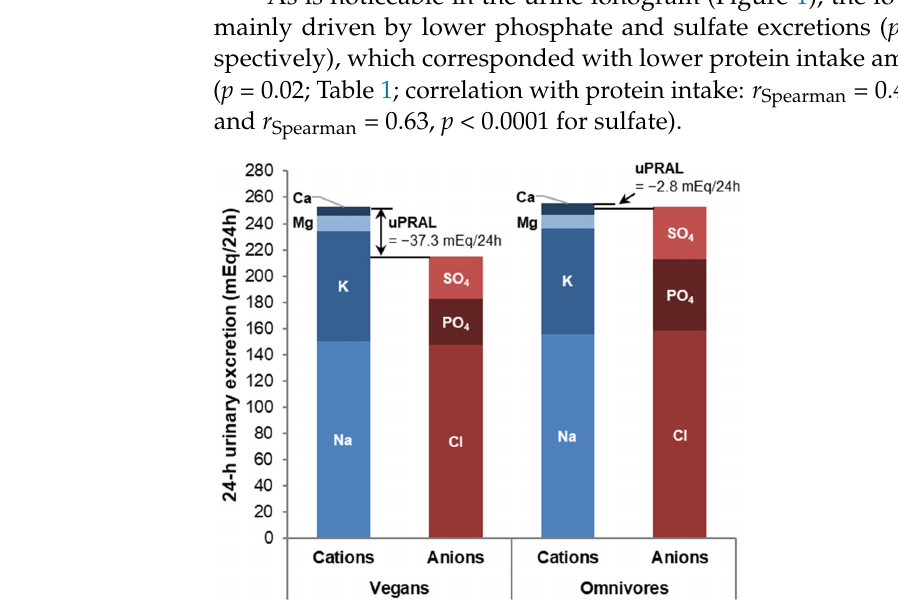
Figure 2. Geometric means and 95% ‐ CI of 24 h urine pH in tertiles of uPRAL for vegans ( n = 34) and omnivores ( n = 35). Among the parameters of bone health, BUA was significantly lower among vegans in comparison to omnivores ( p = 0.037; n = 68; Table 1), which was independent of sex, age, and BMI ( p = 0.045).